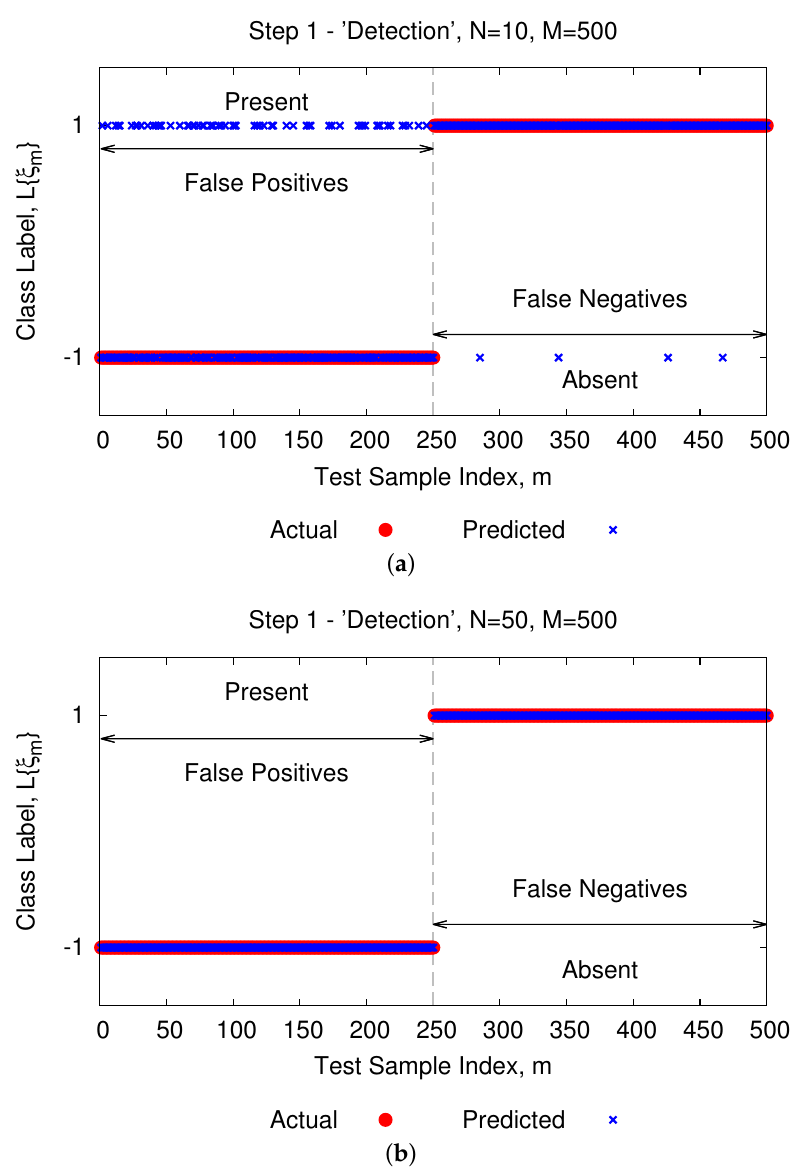
Figure 7. Experimental Assessment. ( V = 8, f 0 = 900 MHz, (cid:101) ε B = 41.8 ε 0 − j 0.97 S = 48.63 ε − j 1.28 , M = 500)—Actual vs. predicted labels when dealing with Step 1 (“Detection”) (cid:101) ε 0 H 2 π f 0 considering ( a ) N = 10 and ( b ) N = 50 training